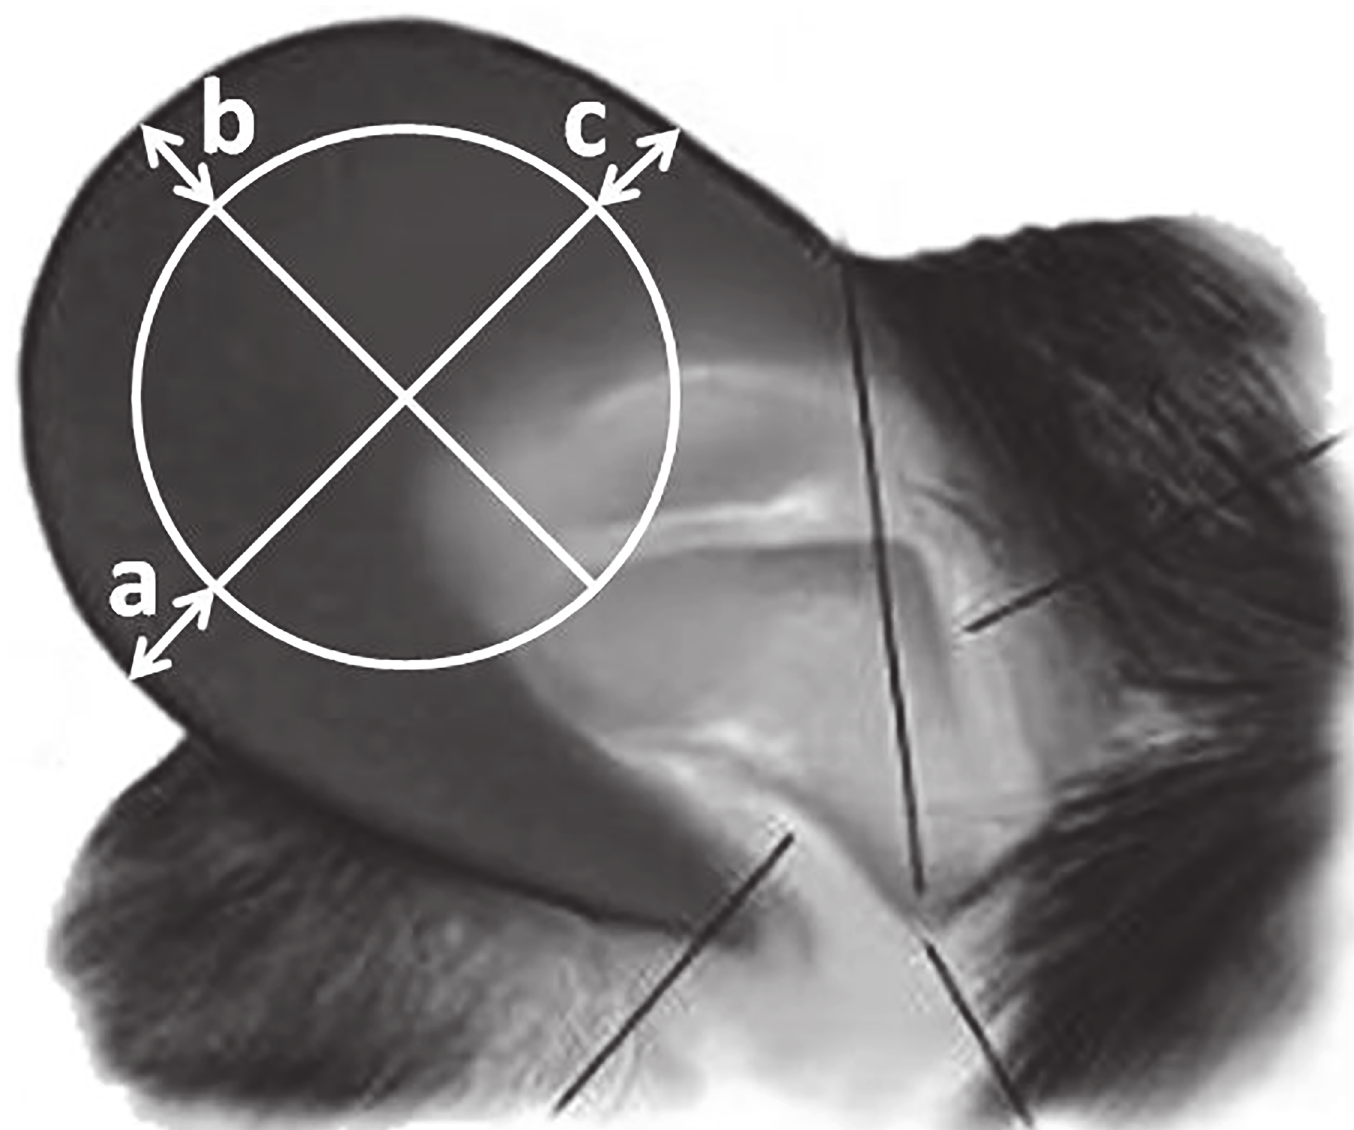
Fig 1. Photo of a mouse pinna with the localization of the round cross section of the caliper measuring the ear thickness (photo from